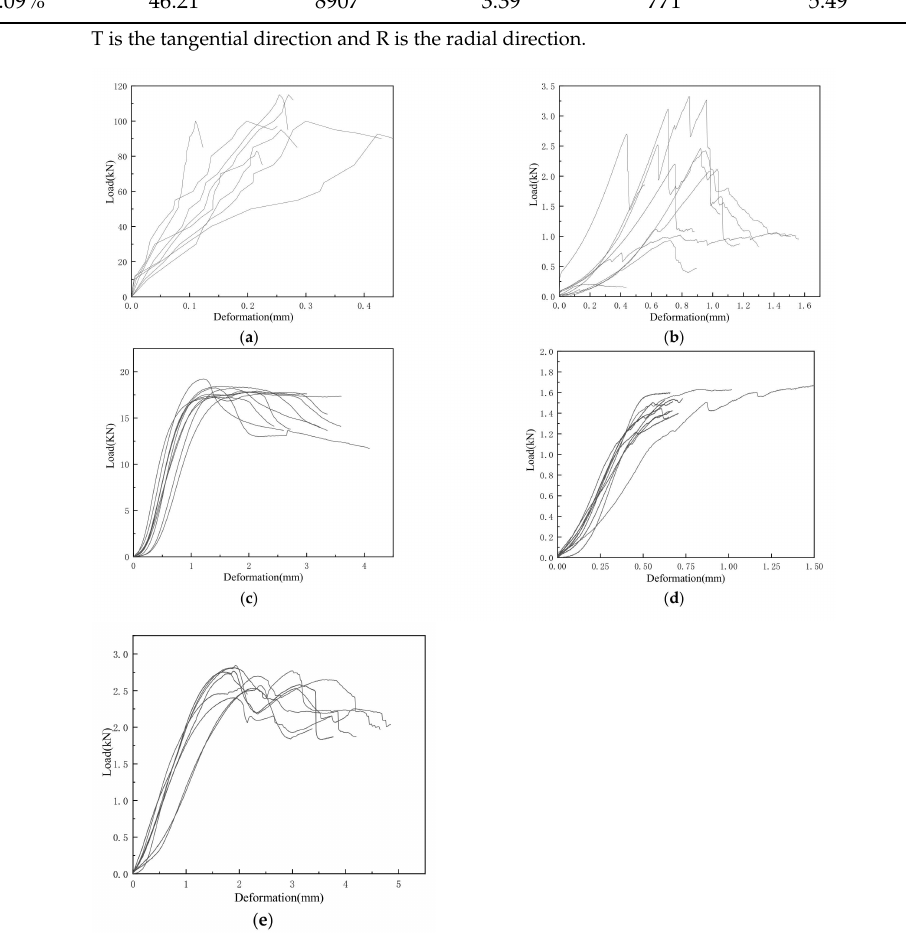
Figure 7. Load–deformation curves of the test samples: ( a ) compressive strength test of the masonry samples; ( b ) shear stress test of the masonry samples; ( c ) compressive strength test of the wood samples (parallel to the grain); ( d ) compressive strength test of the wood samples (perpendicular to the grain, T); ( e ) compressive strength test of the wood samples (perpendicular to the grain,